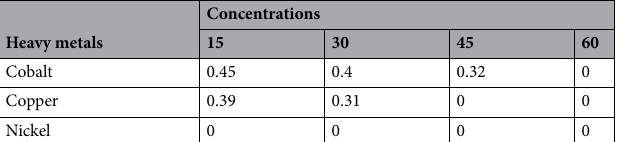
Table 2. Tolerance index levels of Pleurotus sp . in various heavy metals concentrations. Tolerance index rating values indicate: 0.00–0.39—very low metal tolerance. 0.40–0.59—low metal tolerance. 0.60–0.79—moderate